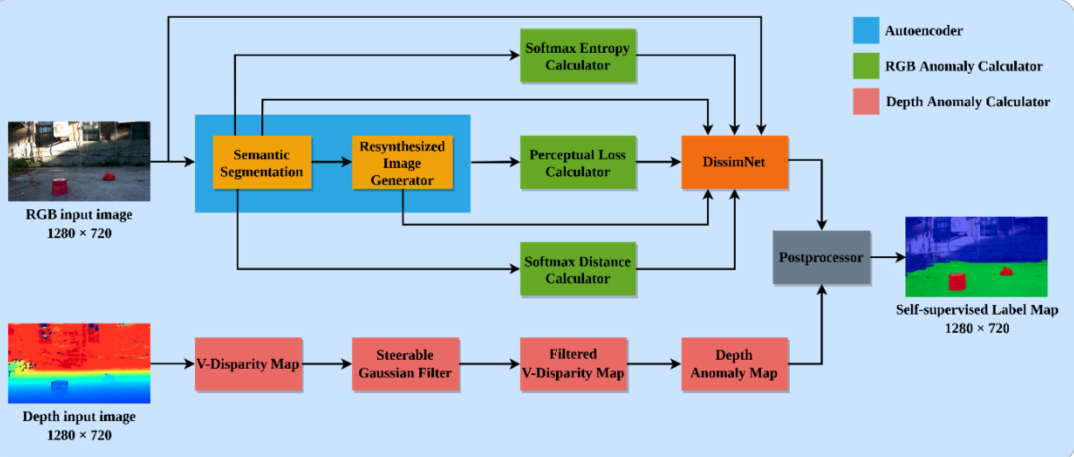
Figure 2. The schematic of our proposed Automatic Generating Segmentation Label system. First, we feed the RGB input image through an autoencoder, which generates a semantic map and resyn- thesized image. Next, an RGB anomaly calculator generates a softmax entropy, softmax distance, and perceptual loss maps from the predicted semantic map. Later, the RGB anomaly map is created by passing the produced images and the RGB input image through the spatial aware dissimilarity module (DissimNet). Additionally, we transform the depth input image to a V-disparity map and filter out noise with a steerable Gaussian filter with second derivatives. The Hough Transform algorithm is then used to extract straight lines from the filtered V-disparity map, resulting in a fast depth anomaly map. Finally, the RGB and depth anomaly maps are delivered to the post processor, which generates the self-supervised label map for drivable area and road anomalies